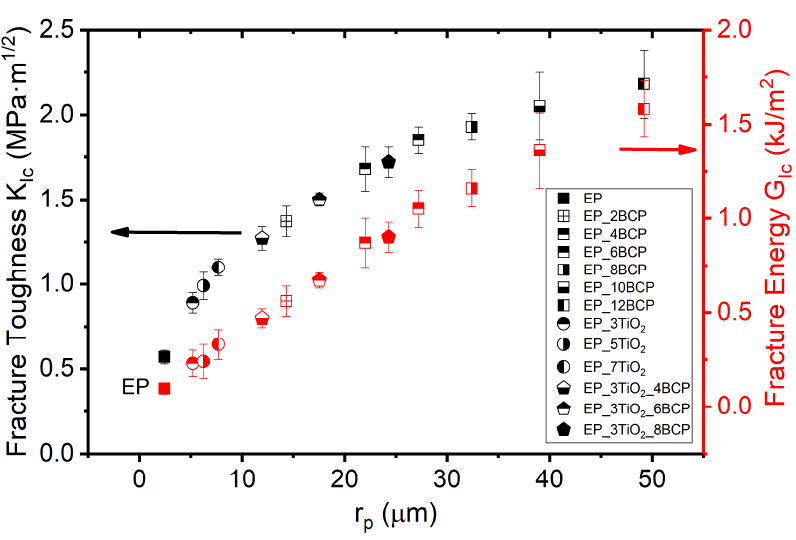
Figure 9 . Fracture toughness and critical energy release rate of BCP, TiO 2 and BCP_ TiO 2 toughened epoxy systems as a function of plastic zone radius r p .